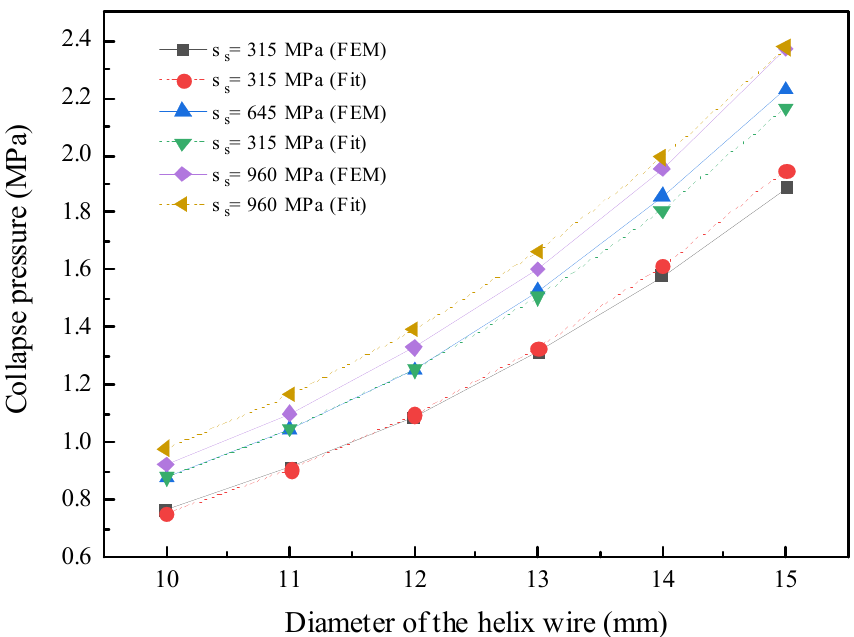
Figure 20. Comparison of FEM and fitting results with respect to different helix wire diameters.